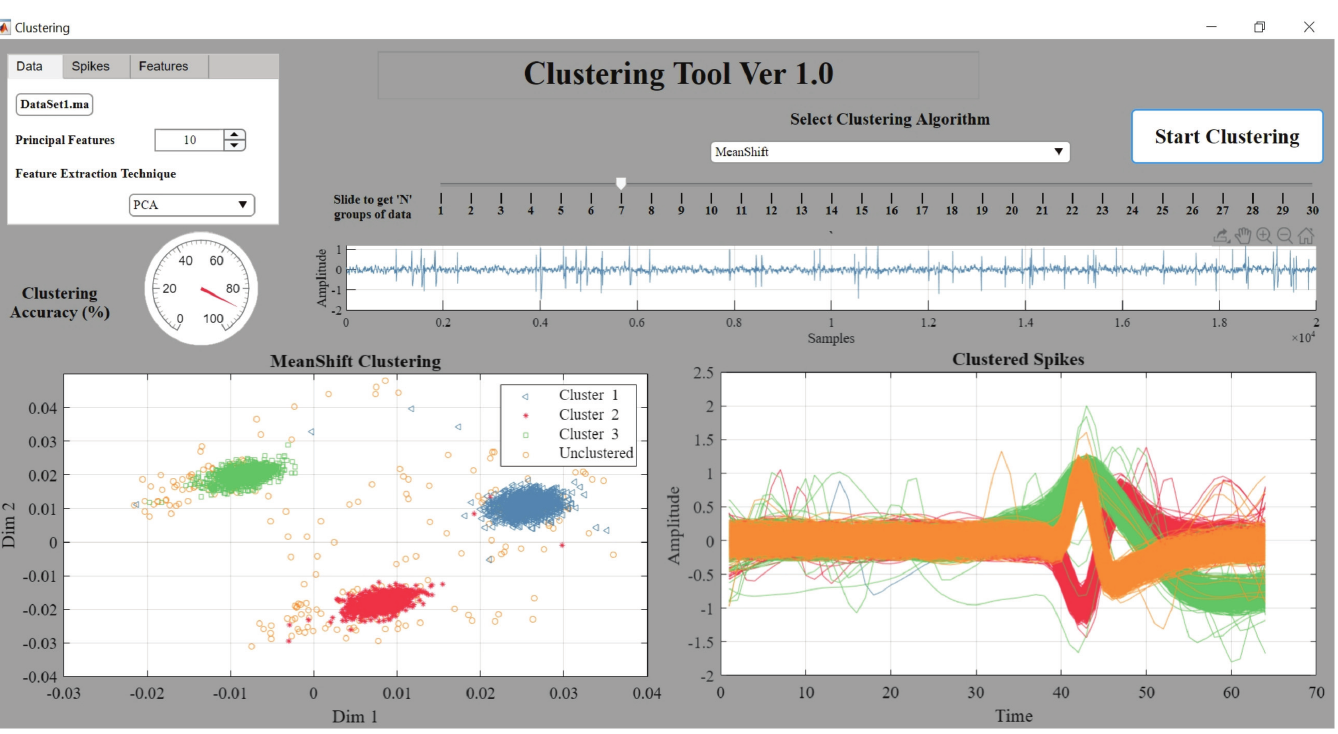
Fig 10. Software for proposed clustering